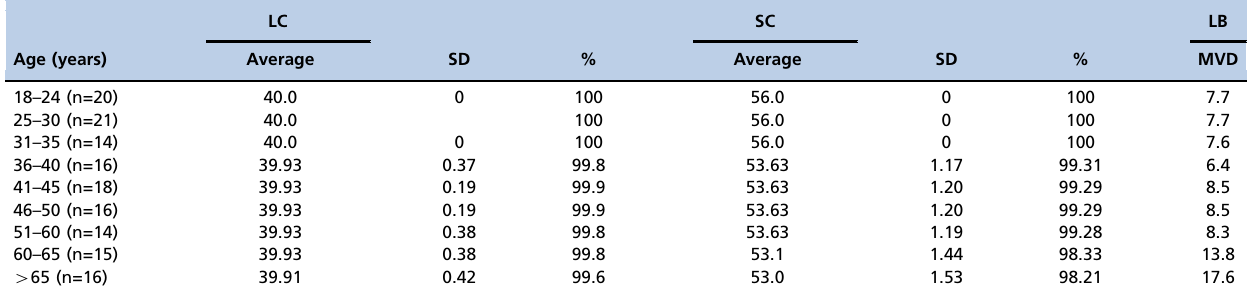
Table 4 - Descriptive table with the results of each USN test expressed in terms of mean, standard deviation and percentiles and stratified by age.